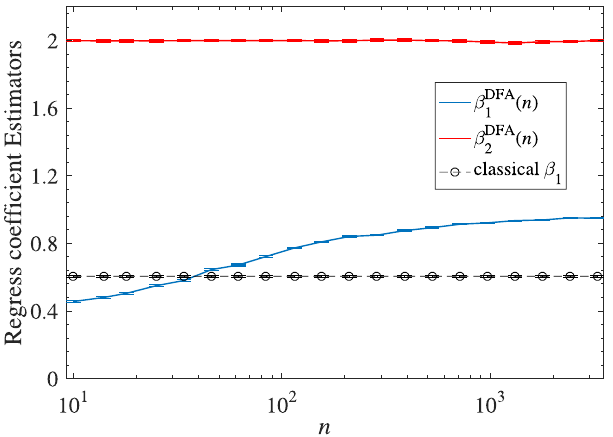
Figure 3. Estimated two DFA Regression coefficients with BMFs model.